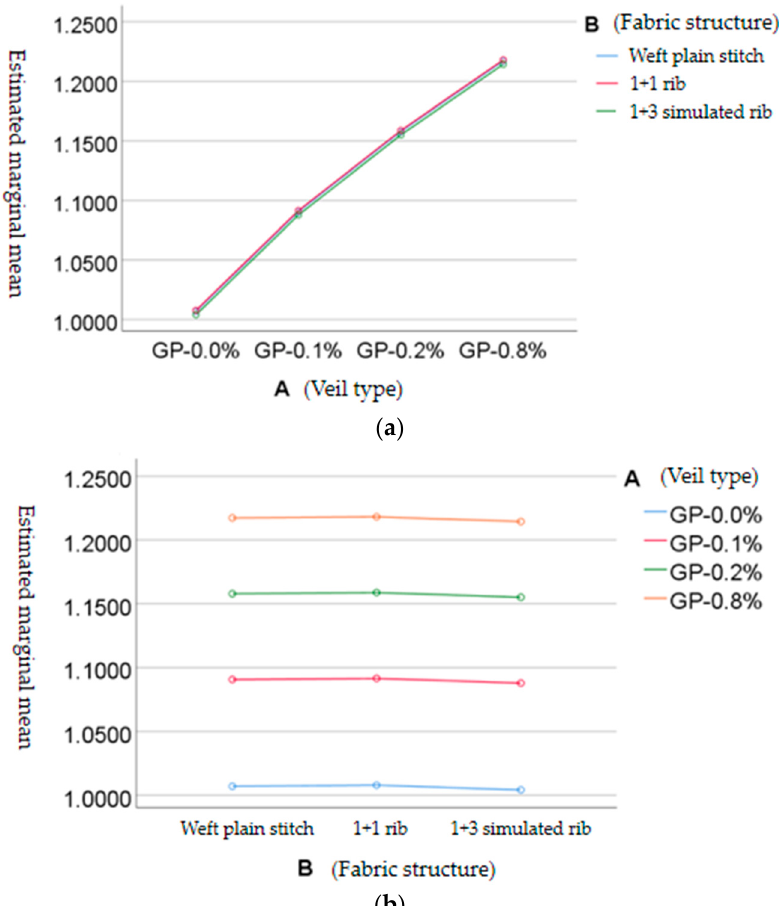
Figure 6. ( a ) Profile of estimated marginal mean value of blood-flow promotion multiple of human- skin microcirculation with independent variable A (veil type); ( b ) profile of estimated marginal mean value of blood-flow promotion multiple of human-skin microcirculation with independent variable B (fabric